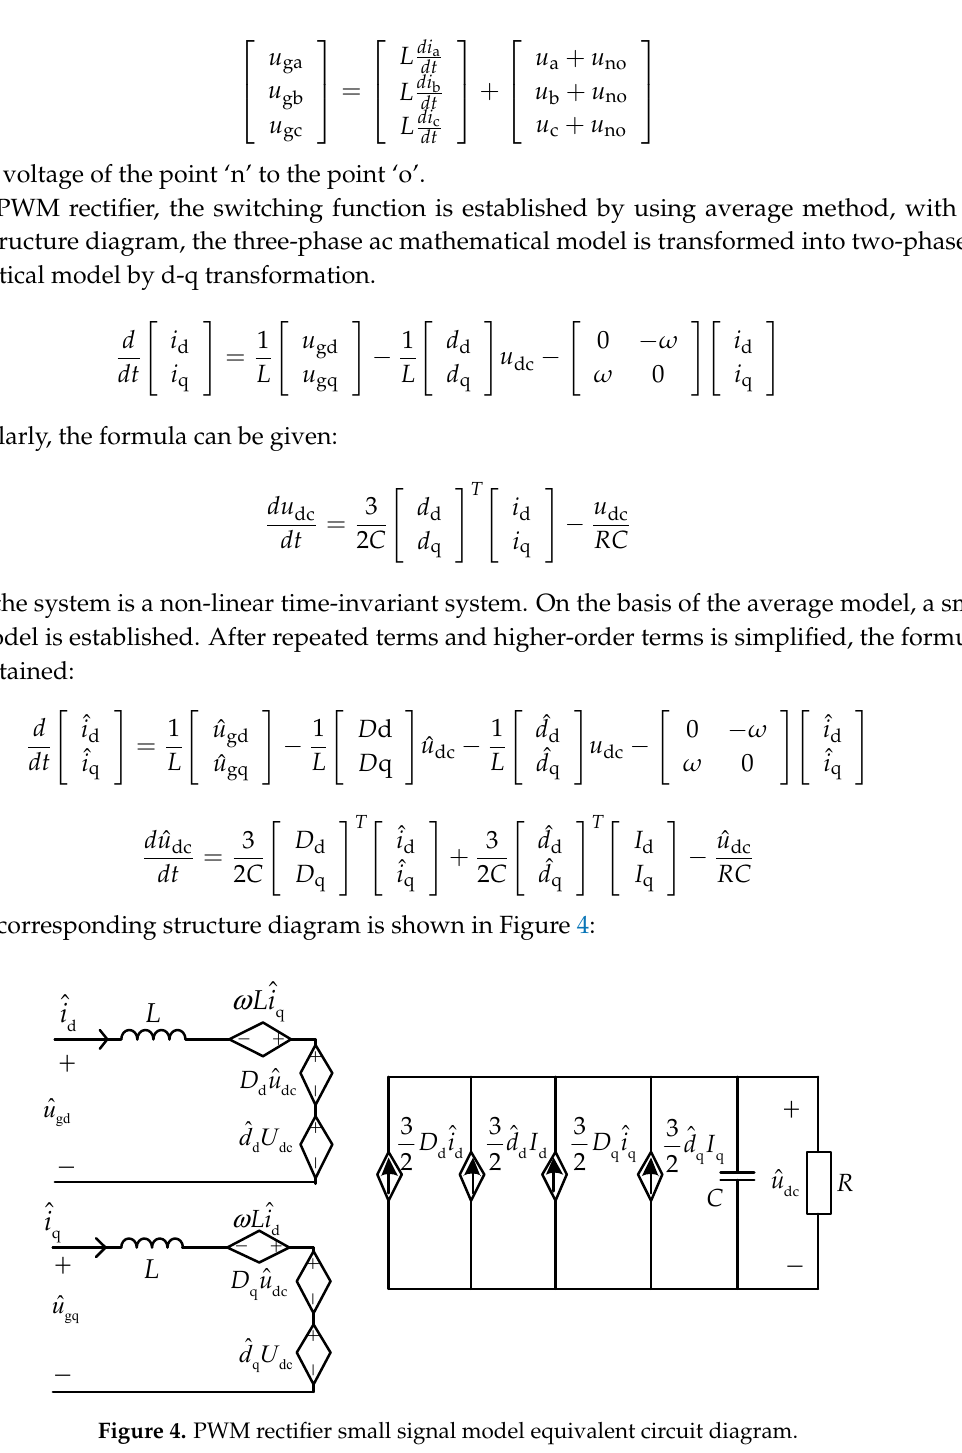
Figure 4. PWM rectifier small signal model equivalent circuit diagram.